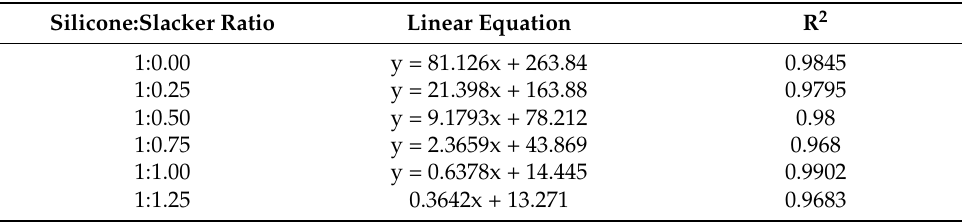
Table A9. Equations and R 2 values for individual trendlines in Figure